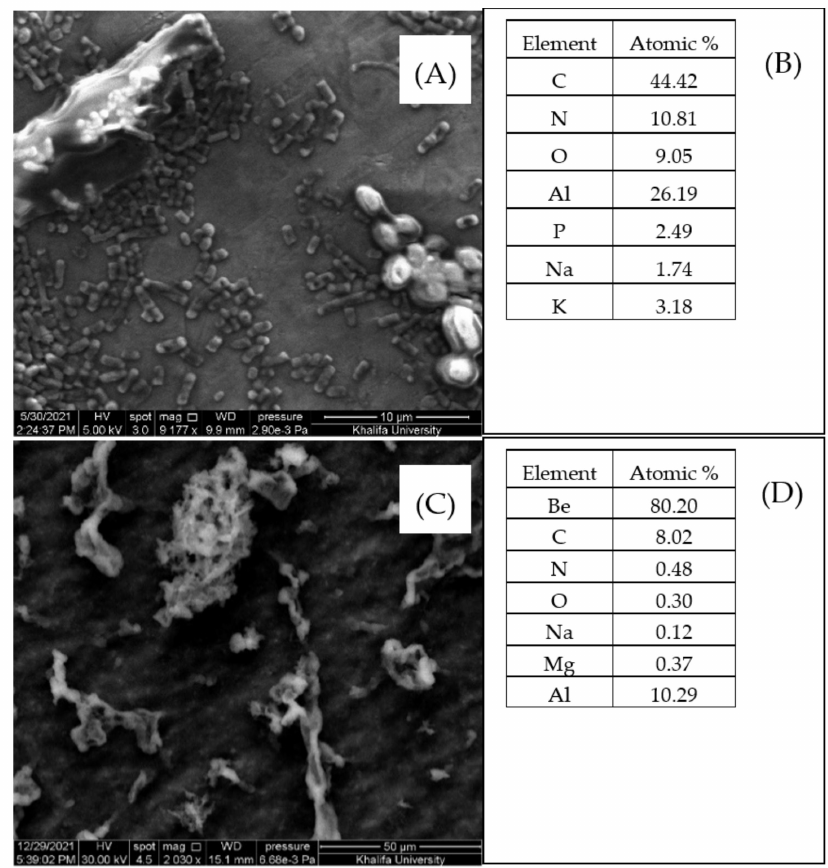
Figure 4. SEM-EDS images and elements of S. lutetiensis ( A , B ) and L. plantarum ( C , D ) and the peaks of the EDS of the main elements.